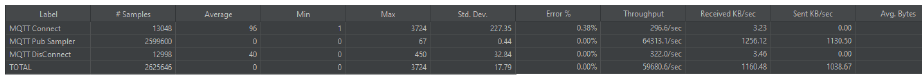
Figure 16. Screenshot of throughput evaluation using the Apache JMeter.